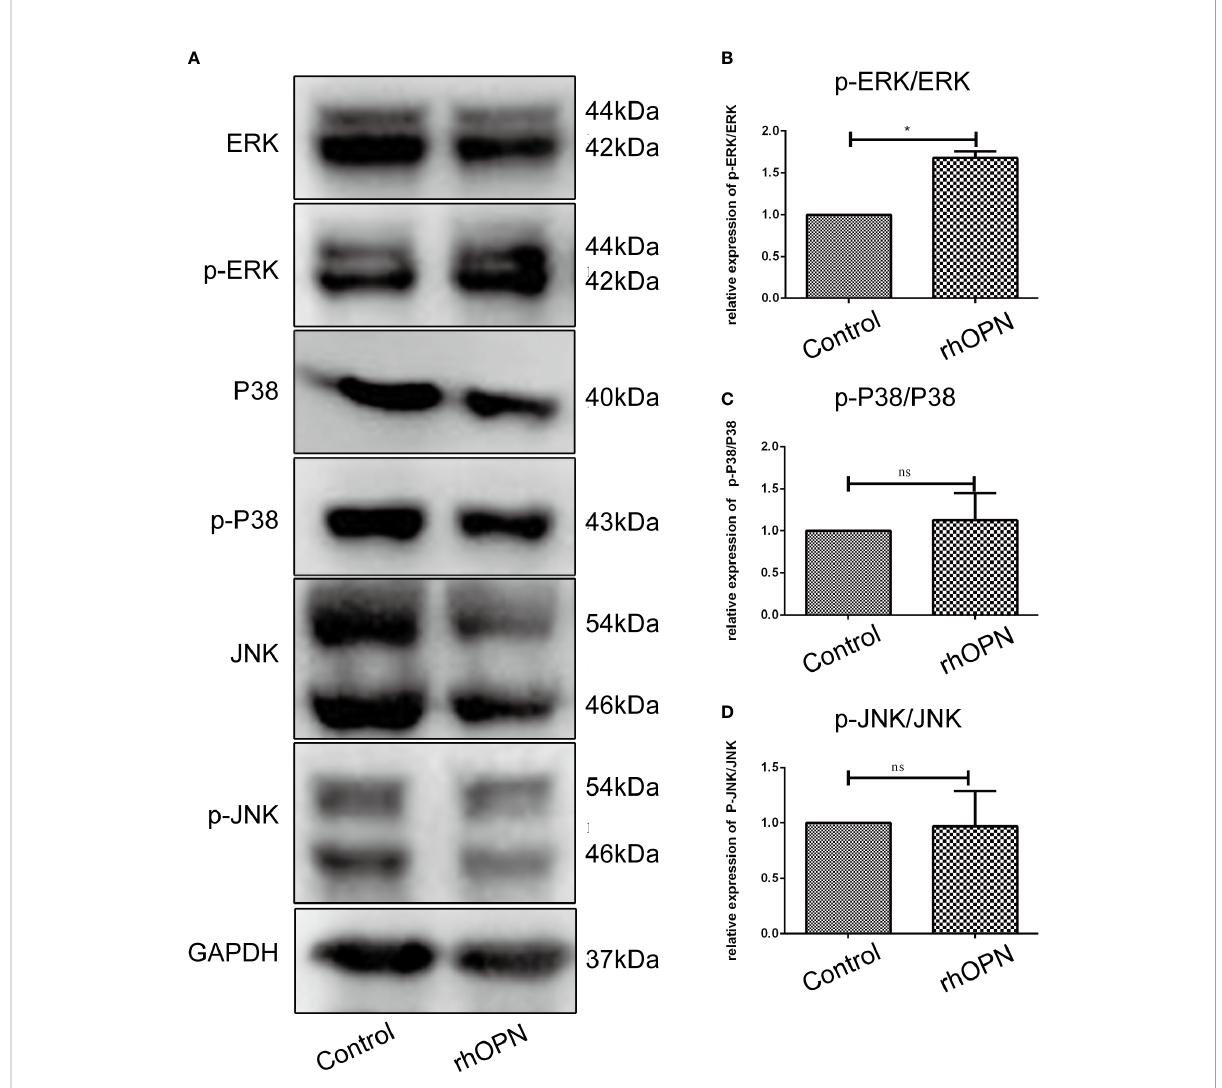
FIGURE 4 (A) Expression of ERK/p-ERK, P38/p-P38, and JNK/p-JNK between the control and rhOPN groups by western blot analysis; (B) Relative expression of p-ERK/ERK between the control and rhOPN groups (n = 3); P = 0.1049; *indicates a signi fi cant difference between the two groups ( P < 0.05); (C) Relative expression of p-P38/P38 between the control and rhOPN groups; (n = 3) ns indicates a lack of signi fi cant differences between the two groups ( P > 0.05); (D) Relative expression of p-JNK/JNK between the control and rhOPN groups (n = 3); ns indicates a lack of signi fi cant differences between the two groups ( P >